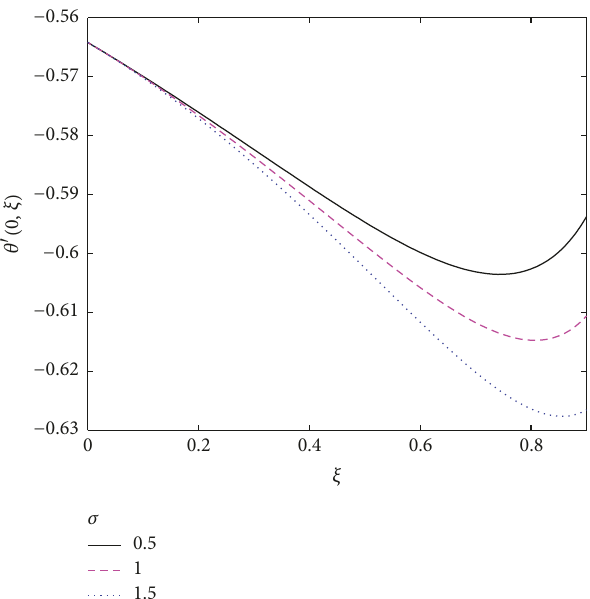
Figure 23: Effect of Sc on 𝜃 󸀠 (0, 𝜉) ( 𝜎 = 𝛾 = 0.5, Pr = 3, 𝜆 = 1, ℏ = −0.5